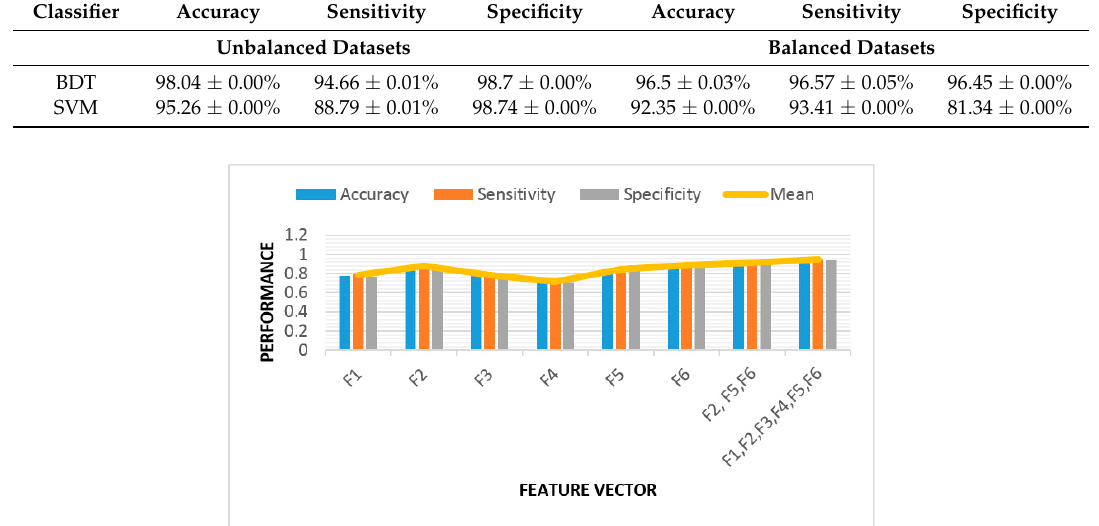
Table 6. Performance of stage 1: VF versus AF detection.